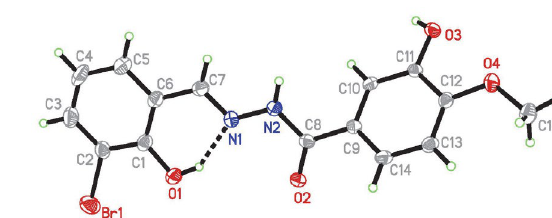
Figure 1. A perspective view of H 2 L 1 with the atom labeling scheme. Thermal ellipsoids are drawn at the 30% probability level. Hydrogen bond is indicated by a dotted line.